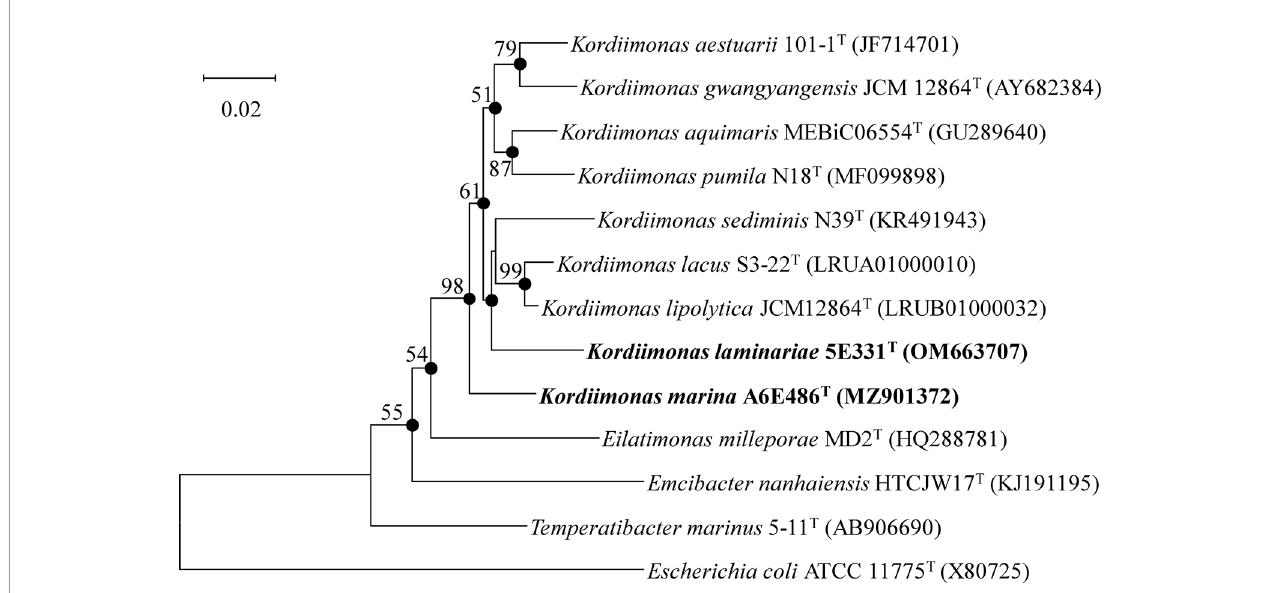
FIGURE 1 | Neighbor-joining phylogenetic tree based on 16S rRNA gene sequences of strains A6E486 T and 5E331 T and other closely related species. Filled circles indicate branches that were recovered with all three methods (neighbor-joining, maximum-likelihood, and maximum-parsimony). Percentage bootstrap values above 50% (1,000 replicates) are shown at branch nodes. Escherichia coli ATCC 11775 T was used as the out-group. Bar, 0.02 substitutions per nucleotide position.